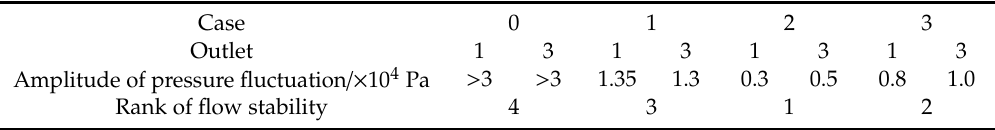
Table 4. The velocity in inlet and outlets in several cases.